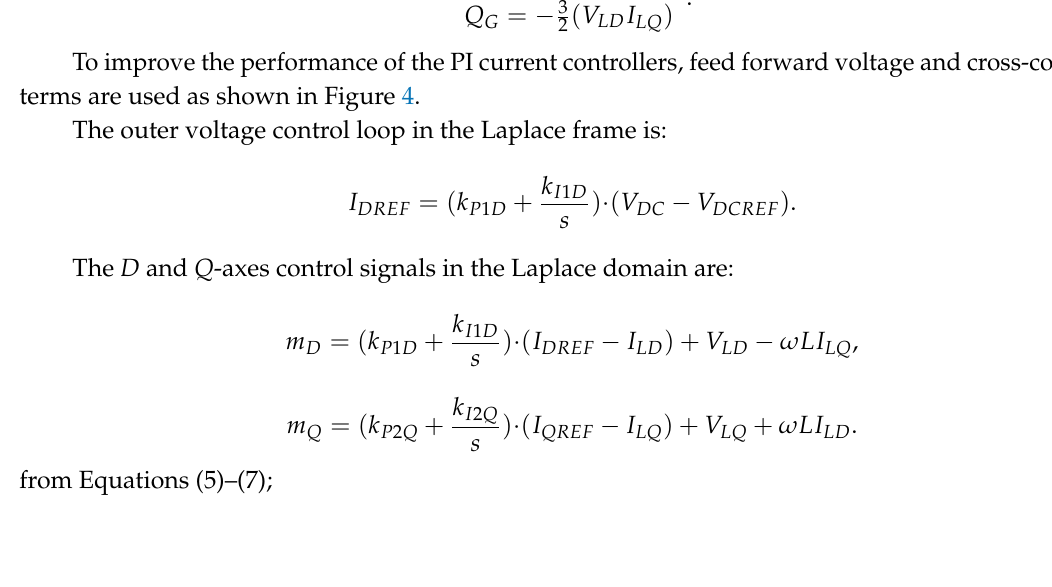
Figure 5. Battery grid connected decoupled controller. 3.4. Diesel Generator Model and Control In grid connected mode, the diesel generator provides real and reactive power and in islanded mode it regulates the microgrid frequency as shown in Figure 6. A synchronous machine with excitation system and a speed governor is used to model the diesel generator. The machine frequency is regulated by the speed governor driven by a diesel engine. Figure 7 shows the diesel engine and speed governor control where the inputs are diesel generator per unit speed ω and per unit speed reference ω ref . The governor output is the per unit mechanical torque T pu which drives the shaft of the synchronous generator. The diesel generator supplies specified reference power at grid frequency in speed-droop mode in grid connected operation, however, to control and maintain a